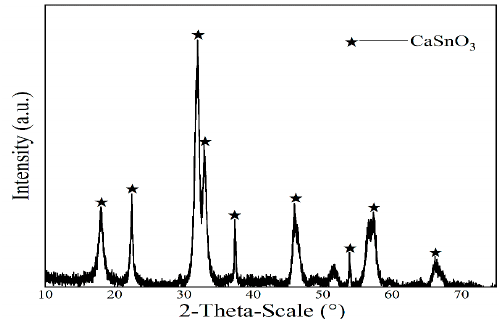
Figure 9. XRD pattern of the calcium stannate obtained.